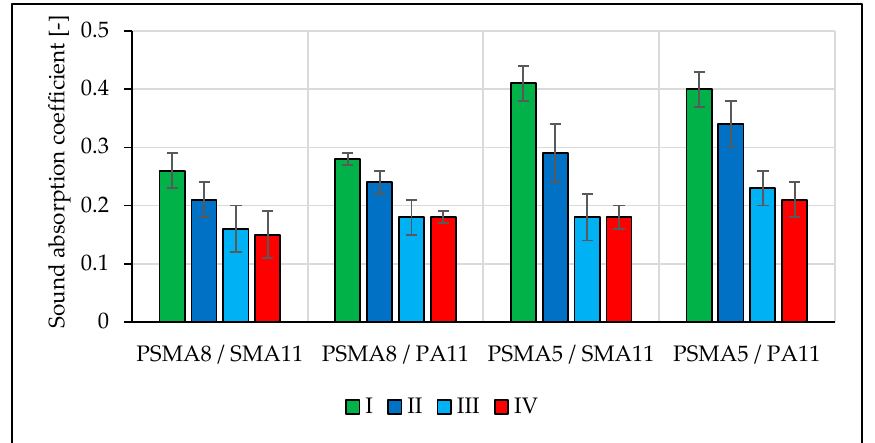
Figure 19. Changes in sound absorption coefficient during pavement service on test sections.